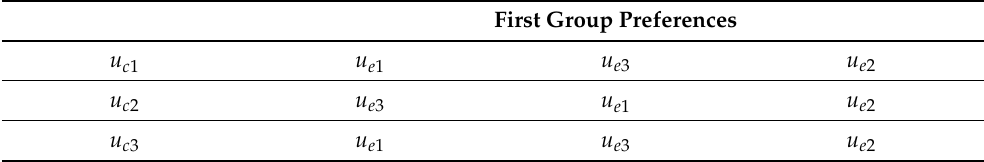
Table 1. The preference list of the cell-center